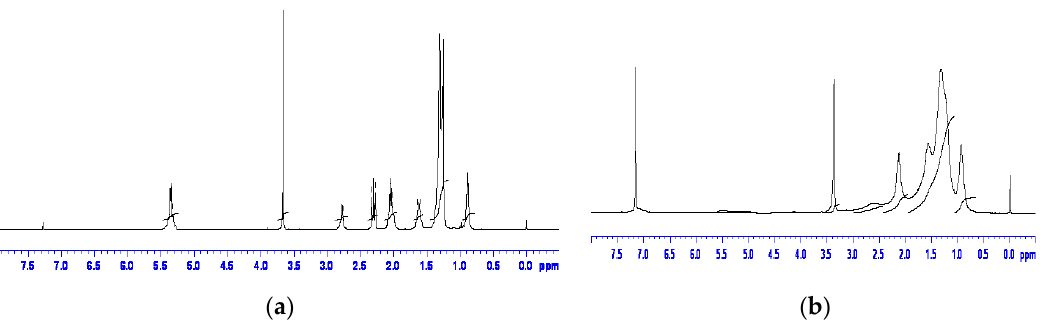
Figure 6. Change in the 1 H-NMR spectrum of soybean BD by accelerated oxidation at 180 °C for 72 h.